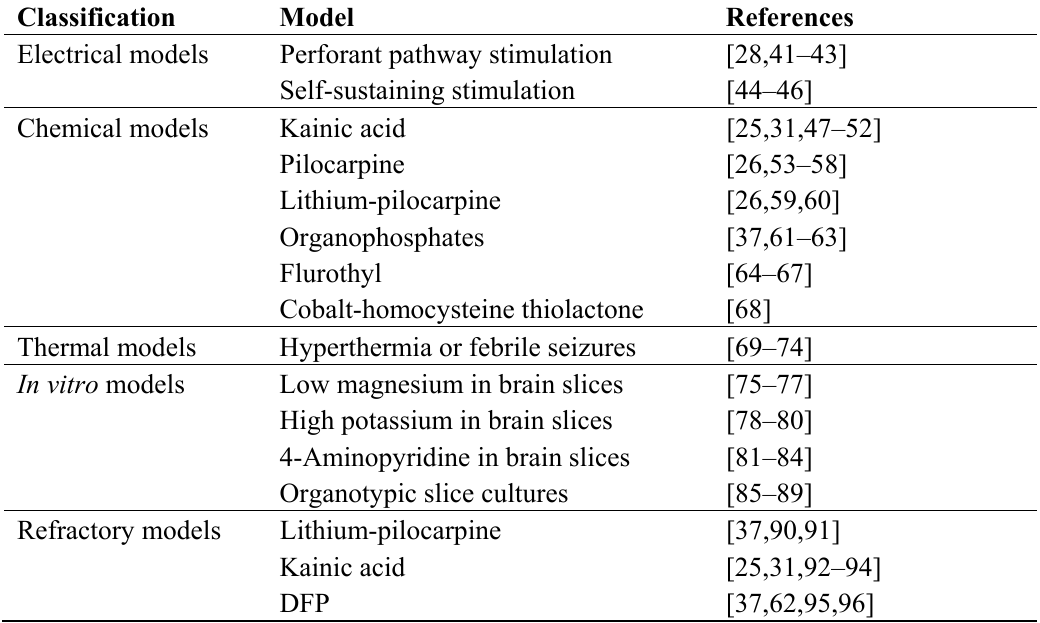
Table 2. Classification of animal models of